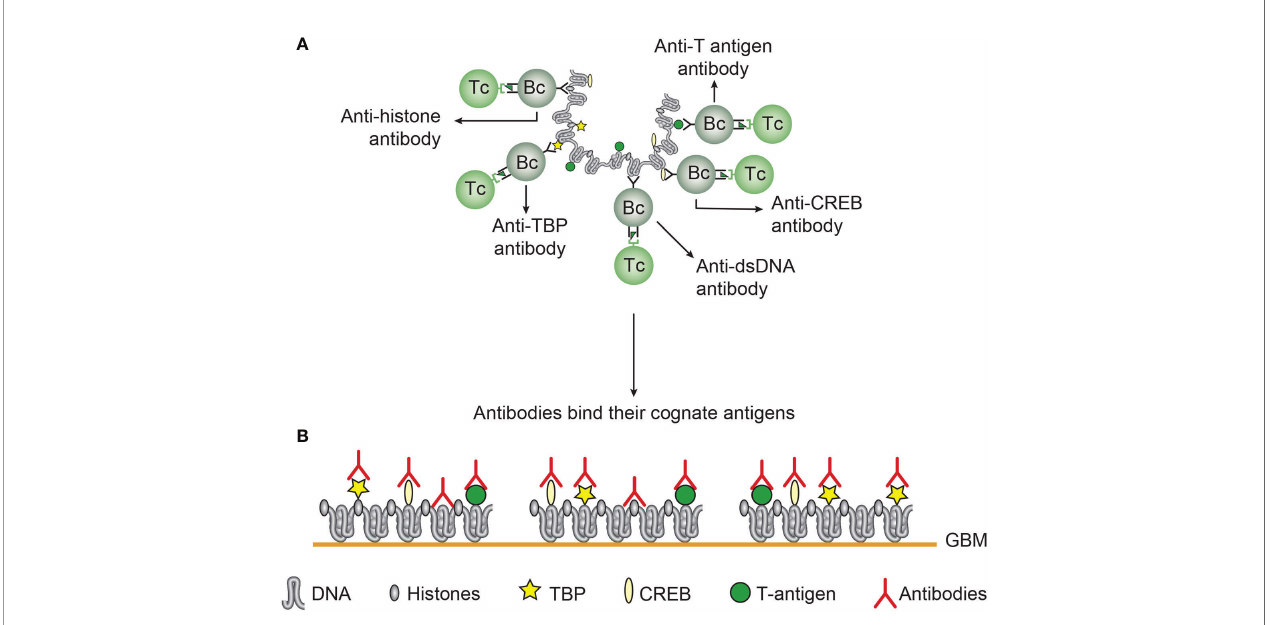
FIGURE 5 | Chromatin structures and immunogenic chromatin-associated proteins are accessible and may stimulate B and T cells. In the fi gure all the selected molecules are accessible to B cells. As in (A) , polyomavirus T antigen is associated with chromatin in virus-infected cells, and all chromatin-speci fi c B cells may present T antigen peptides to cognate T helper cells. This results in production of antibodies against unique DNA and chromatin/protein structures. Since these antigens are accessible to B cell antigen receptors, circulating antibodies may have the potential to bind the same specter of accessible antigens in chromatin exposed in e.g. glomerulus basement membranes (B) . This demonstrates that chromatin-speci fi c antibodies per se may have pathogenic potentials, and not only anti-dsDNA antibodies. This model emerges from experimental data (see text). [This fi gure is modi fi ed from: Figure 5 in reference